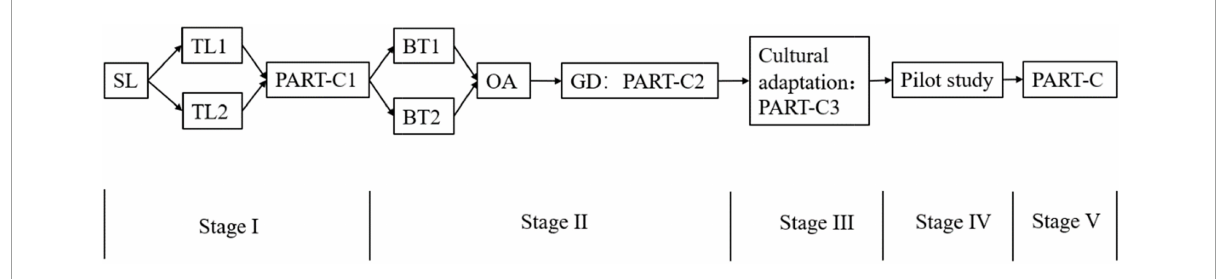
FIGURE1 The structured flowchart of the translation process. SL, Source Language; TL, Target Language; BT, Back Translation; OA, Original Author; GD, Group